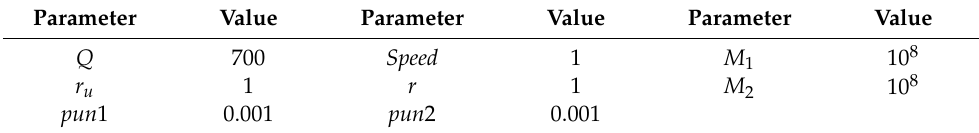
Table 3. Routing parameters in NR-EGA.